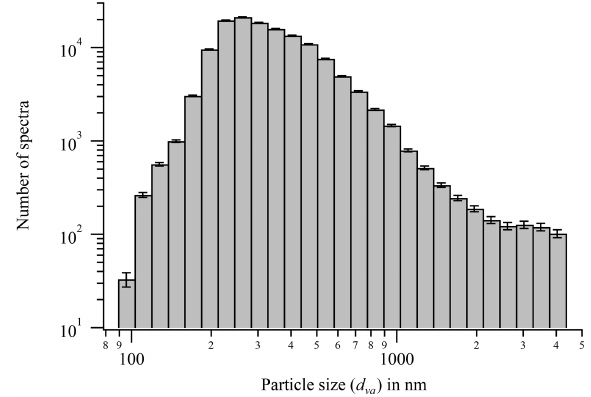
Figure 8. Size (vacuum aerodynamic diameter – d va ) distribution of single particles calculated by the optical detection system of the ERICA-LAMS during all StratoClim flights (KTM 1–8) performed in Nepal in 2017. This distribution covers particles from the bound- ary layer up to the